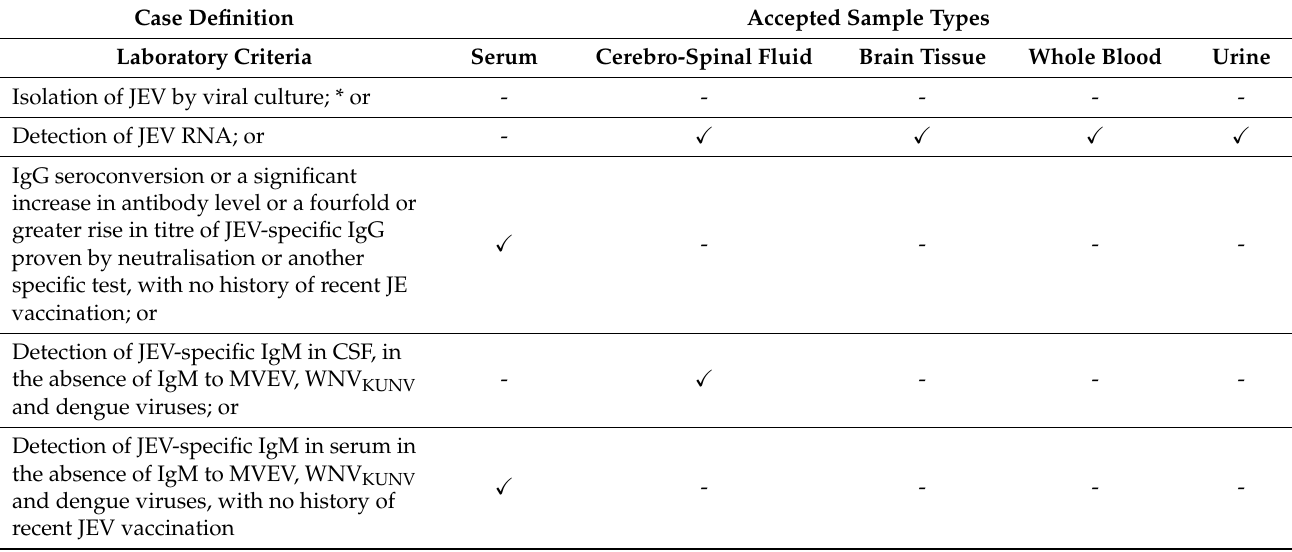
Table 1. Case definition for Japanese encephalitis based on national case definitions, and accepted sample types for Japanese encephalitis virus testing in this